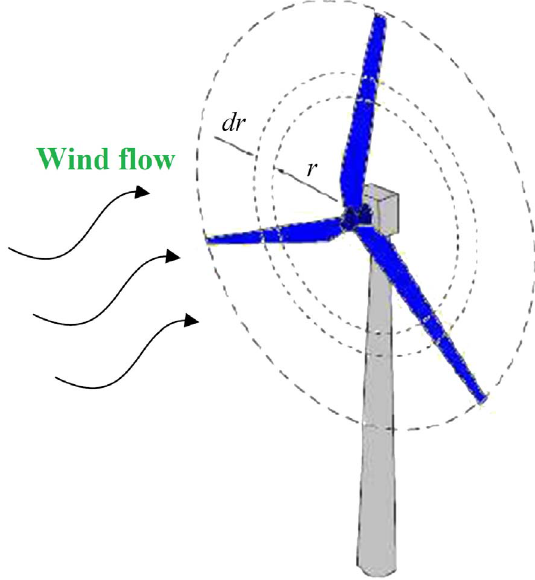
Figure 1. A HAWT having three blades.